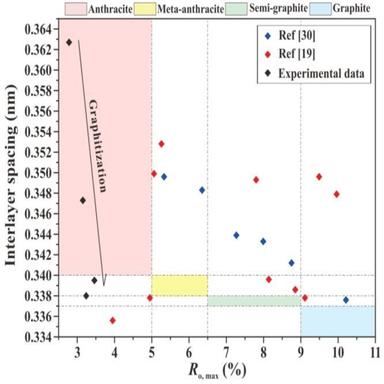
Variation of interlayer spacing with Ro, max for high rank coal (The classification of anthracite, meta-anthracite, semi-graphite and graphite were provided by; Blue point data were measured from HRTEM by ; Red point data were calculated from XRD by ). (For interpretation of the references to colour in this figure legend, the reader is referred to the web version of this article.)